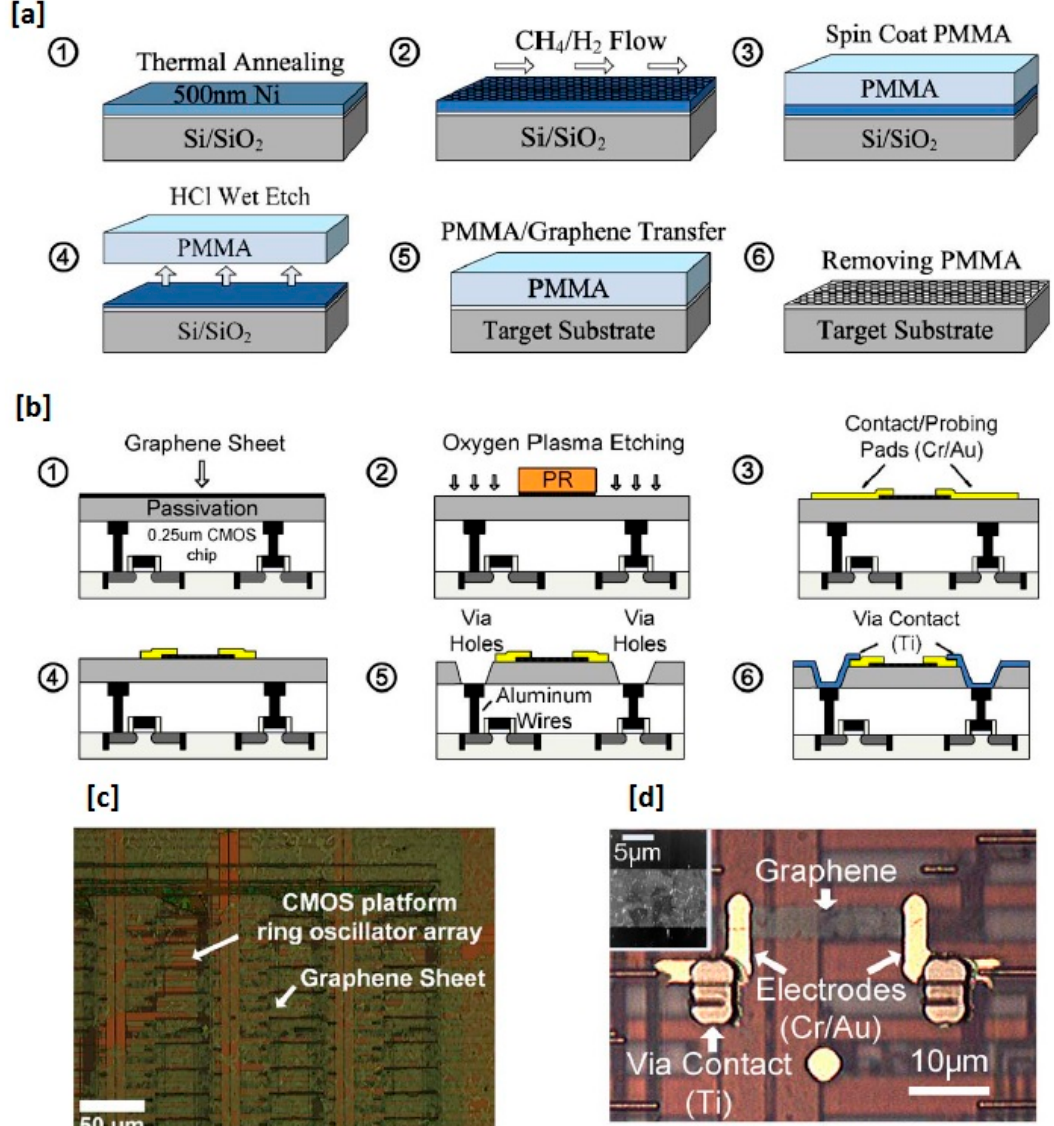
Figure 7. Process flows of as-fabricated on-chip graphene interconnect. ( a ) Transfer of CVD-grown graphene to target substrate; ( b ) integration of graphene with complementary metal oxide semiconductor (CMOS) circuitry; ( c ) optical image of CMOS ring oscillator array locating graphene sheet; ( d ) optical image of one fabricated graphene interconnect on top of the CMOS ring oscillator array. (Inset) AFM image of graphene stripes [52]. Reproduced with permission from [52]. IEEE, 2010.